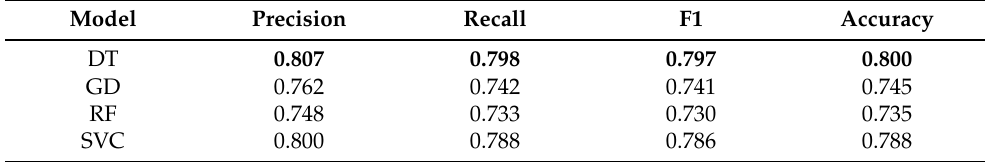
Table 1. Performance analysis of the ML algorithms for polarity detection in user responses.